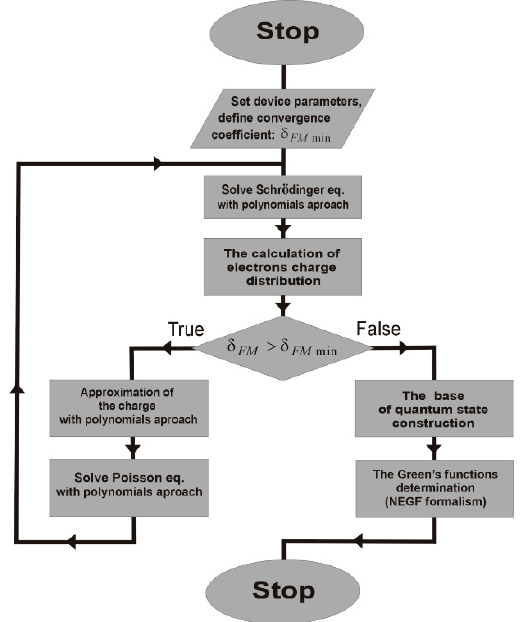
Figure 2. The main algorithm for self-consistent solving the Schrödinger and Poisson equations in the process of QCL simulations.